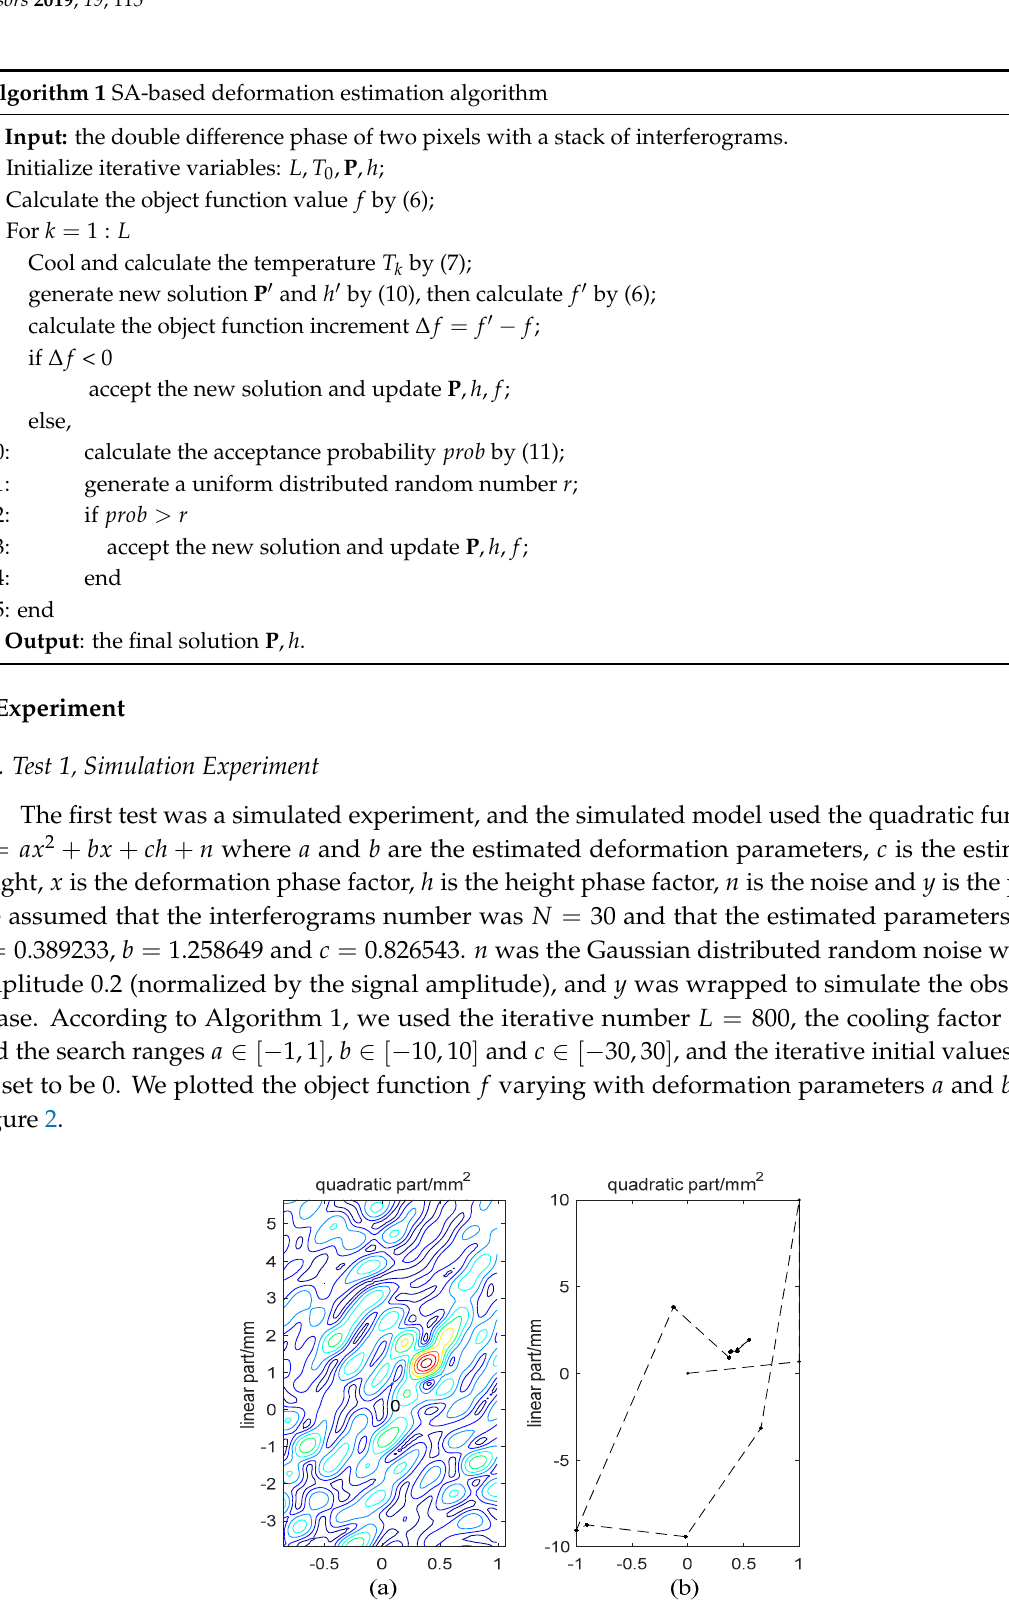
SA ILS Figure 3. With different Gaussian white noise levels, the linear ( a ) and quadratic ( b ) estimated errors of SA (red) and ILS (blue) algorithm. From Figure 3, we can learn that these two algorithms get similar results with Gaussian noise, and ILS algorithm is slightly better than SA algorithm (ILS has the highest probability of integer variables estimation [28]). Both algorithms satisfy the accuracy need of the deformation estimation problem. As for time complexity, the ILS algorithm is affected by the number of interferograms, and adding more variables will increase its complexity too. However, the SA-based algorithm only relies on its iteration numbers. In this test, the average runtime of the ILS algorithm on MATLAB was 207